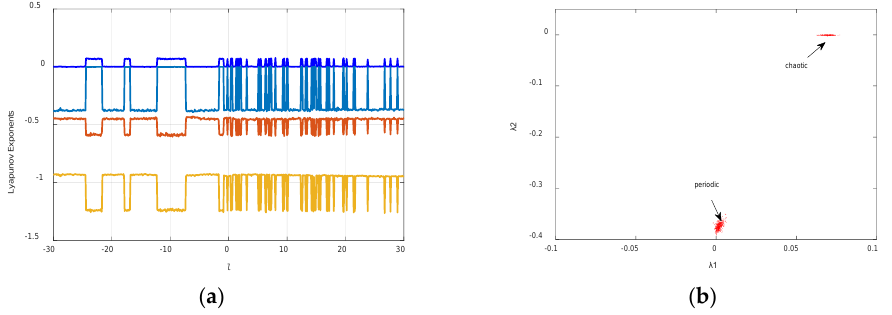
Figure 16. Dynamical behaviors of System (14) on the initial condition (0.1, 0, 1.68, 0.1) versus offset booster l ( l ∈ [ − 30, 30]): ( a ) Lyapunov exponent spectrums, ( b ) distribution of Lyapunov exponents.